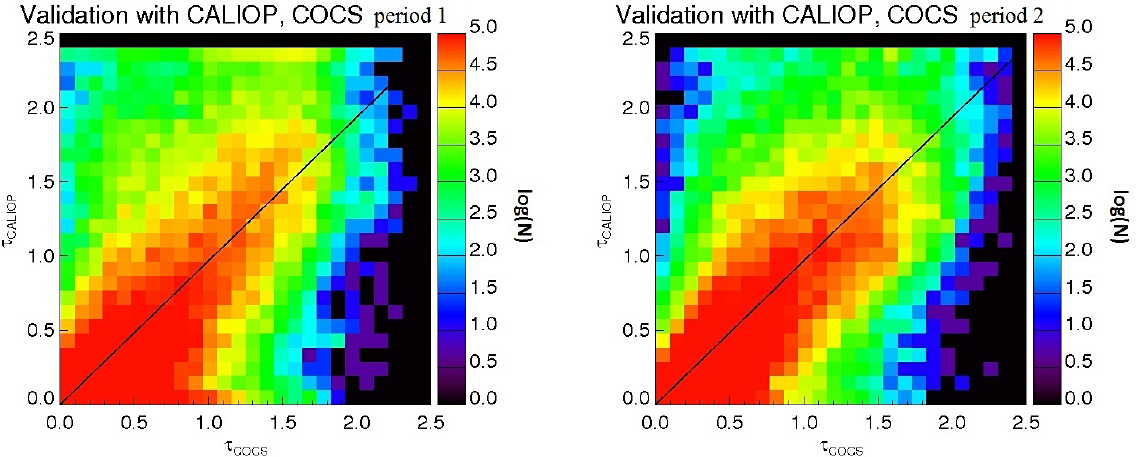
Figure 6. Scatter plot of the cirrus optical thickness τ of CALIOP and COCS: period 1 (left) and period 2 (right). Colours show the number of occurrences on a logarithmic